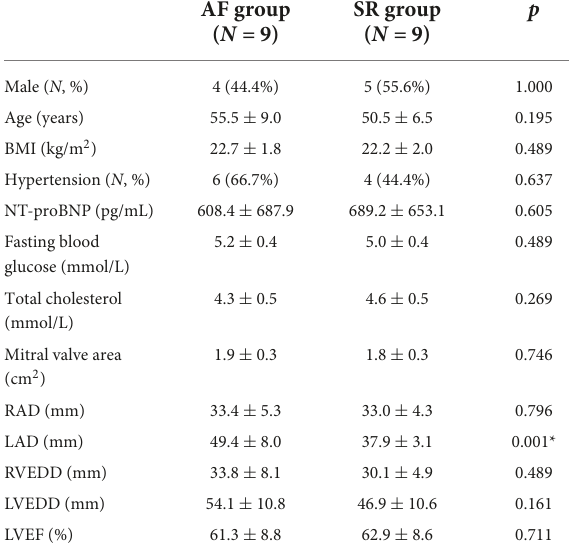
TABLE 1 Clinical baseline characteristics of the AF and SR group